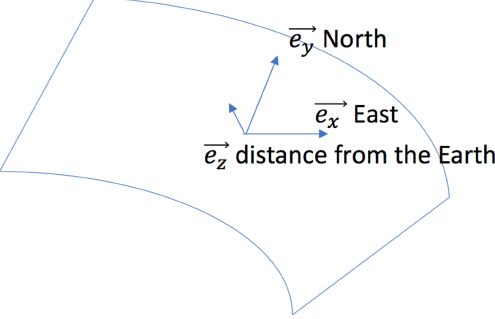
Figure 1. Local coordinate system. In the horizontal plane are de- fined two axes by unit vectors: e x oriented to the east and e y ori- ented to the north. The vertical axis to the horizontal plane is de- fined by unit vector e z ; along this axis is defined the distance of the horizontal plane from the Earth’s